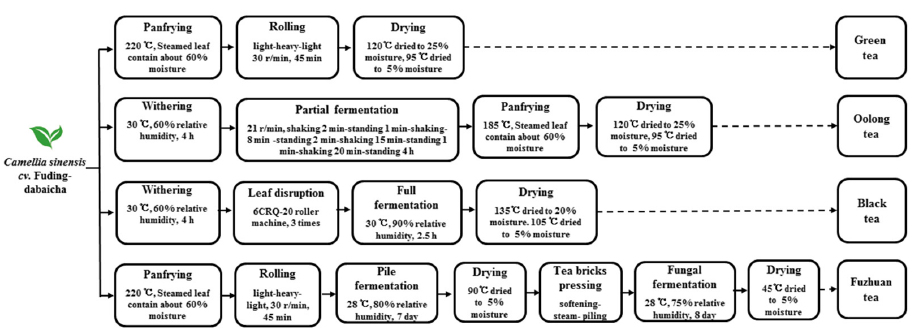
Figure 1. Main manufacture process of various